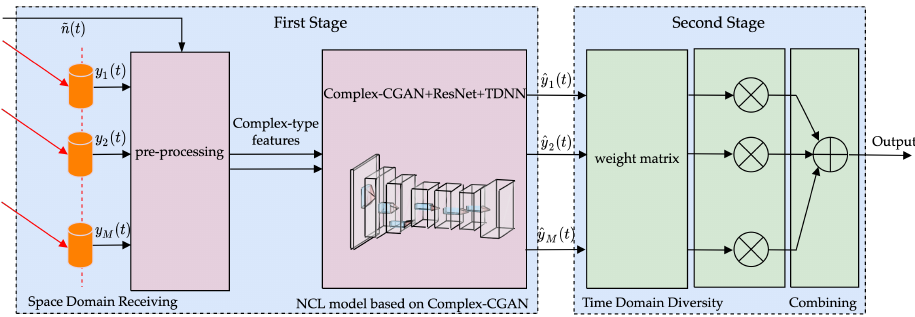
Figure 4. Two-stage structure of the proposed